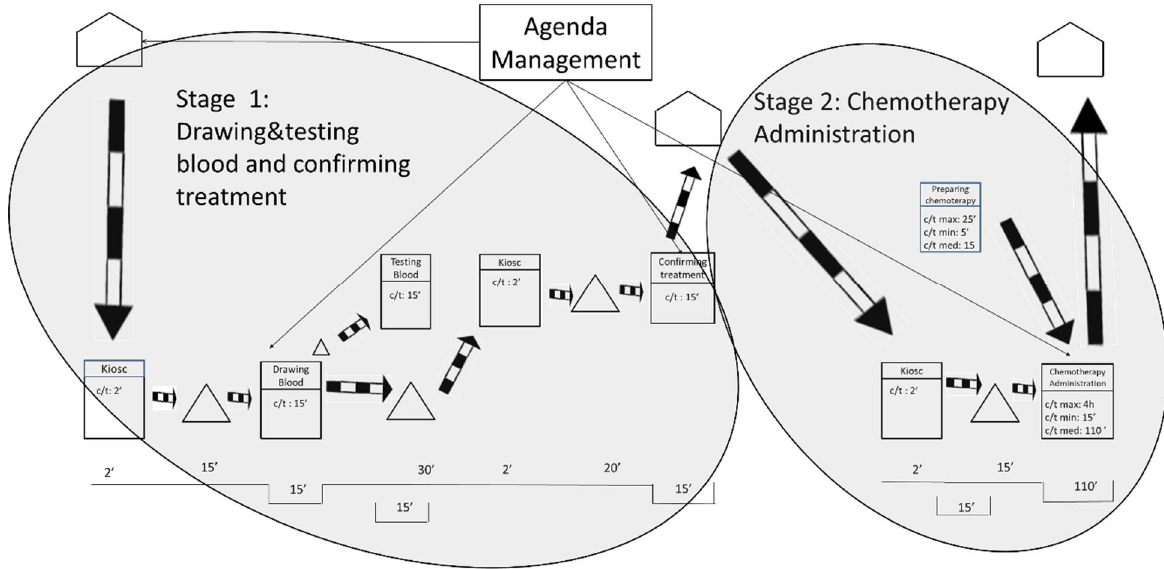
Figure 6. Future State Map 1.